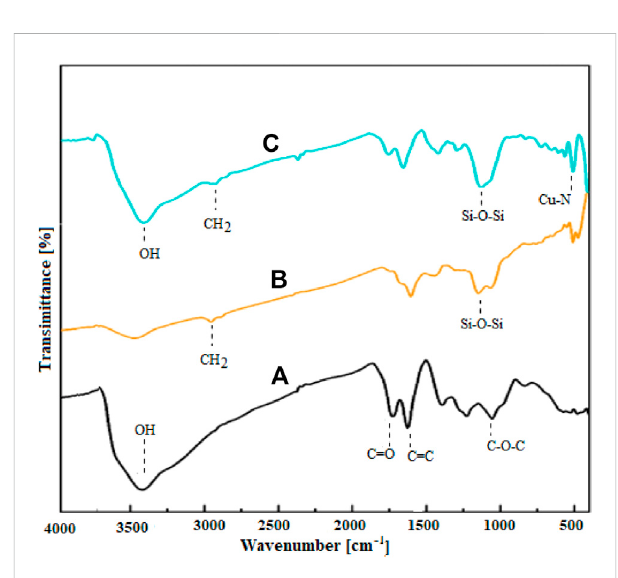
FIGURE 1 FT-IR spectra of (A) GO, (B) GO-Cl, and (C)